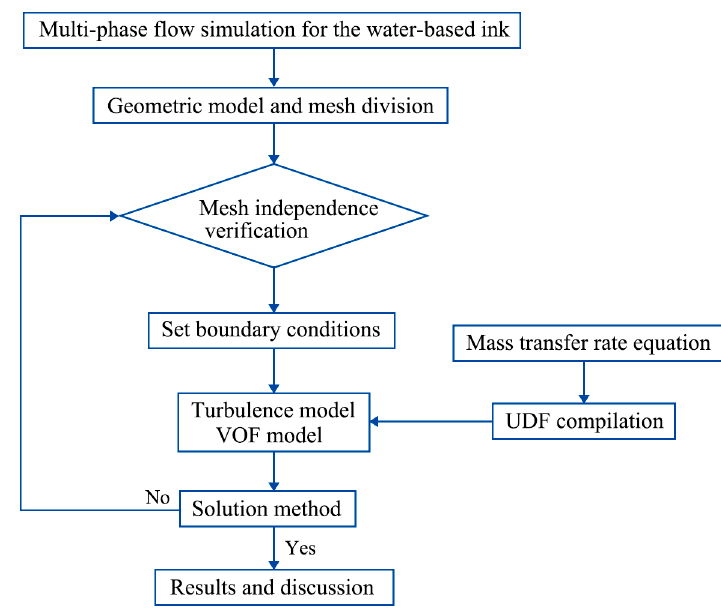
Figure 1. Framework for the